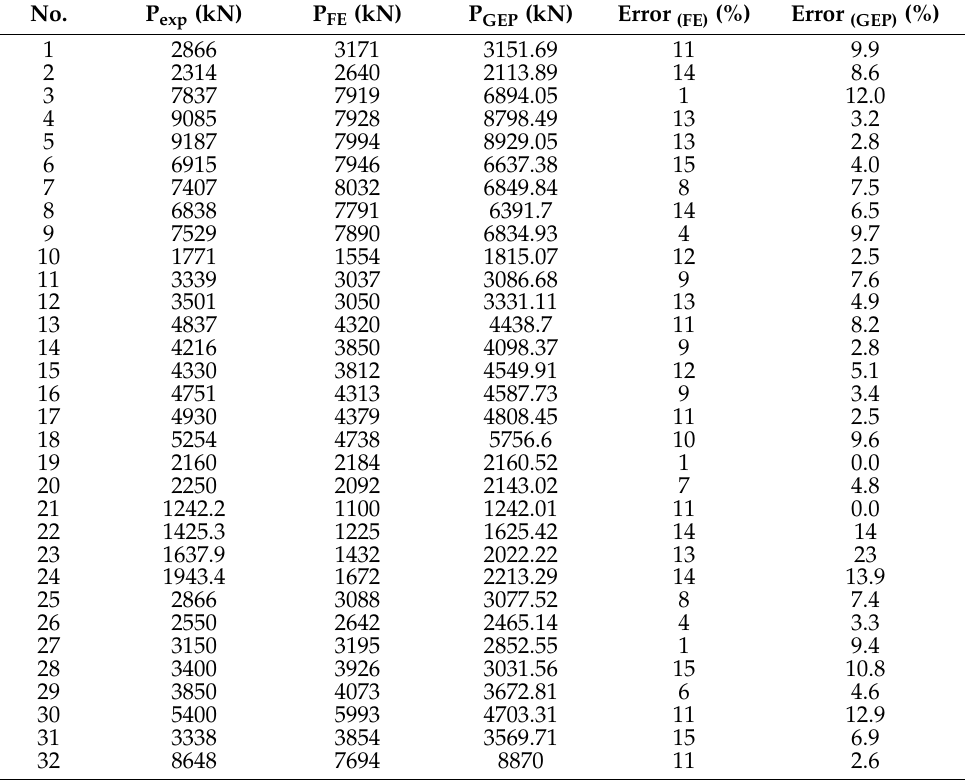
Table 3. Comparison of the GEP equation results and the FEA results with the experimental test